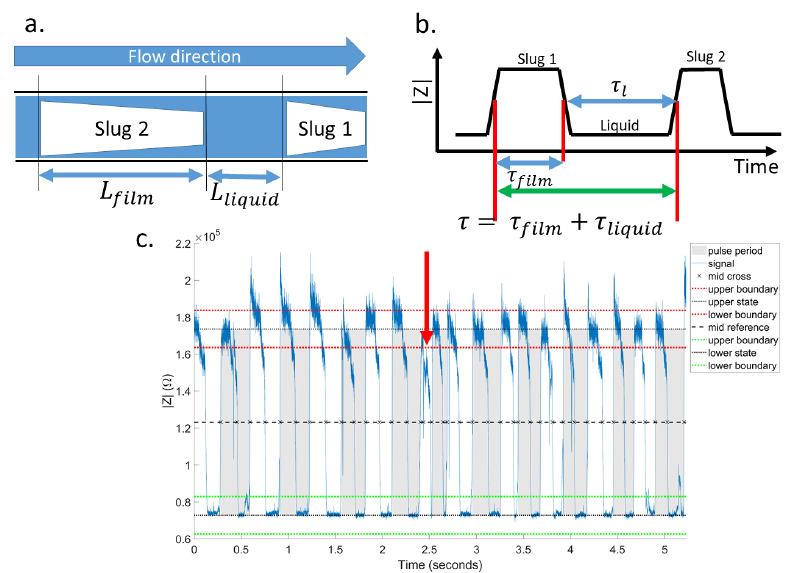
Figure 19. ( a ) Representation of slugs in updated 3-zone-model passing in microchannel boiling [8]. ( b ) Impedance measurements signal using implemented sensors [36]. ( c ) Slug flow impedance signal for 5 s. The red arrow shows an example of a slug that has lower impedance level comparing to the other slugs impedance amplitude.